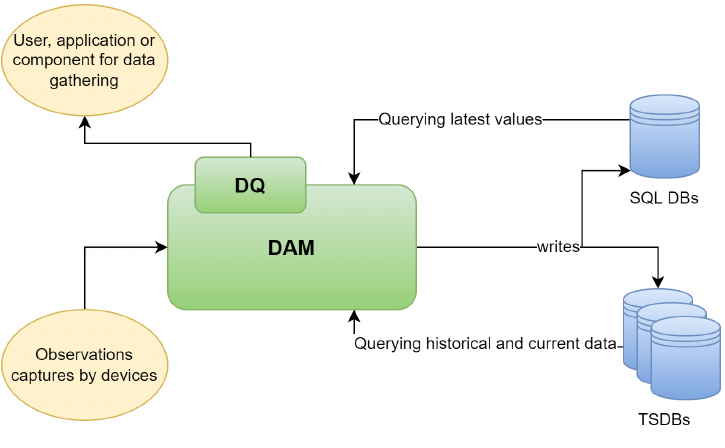
Figure 10. Data Access Manager & Data Query (DAM &